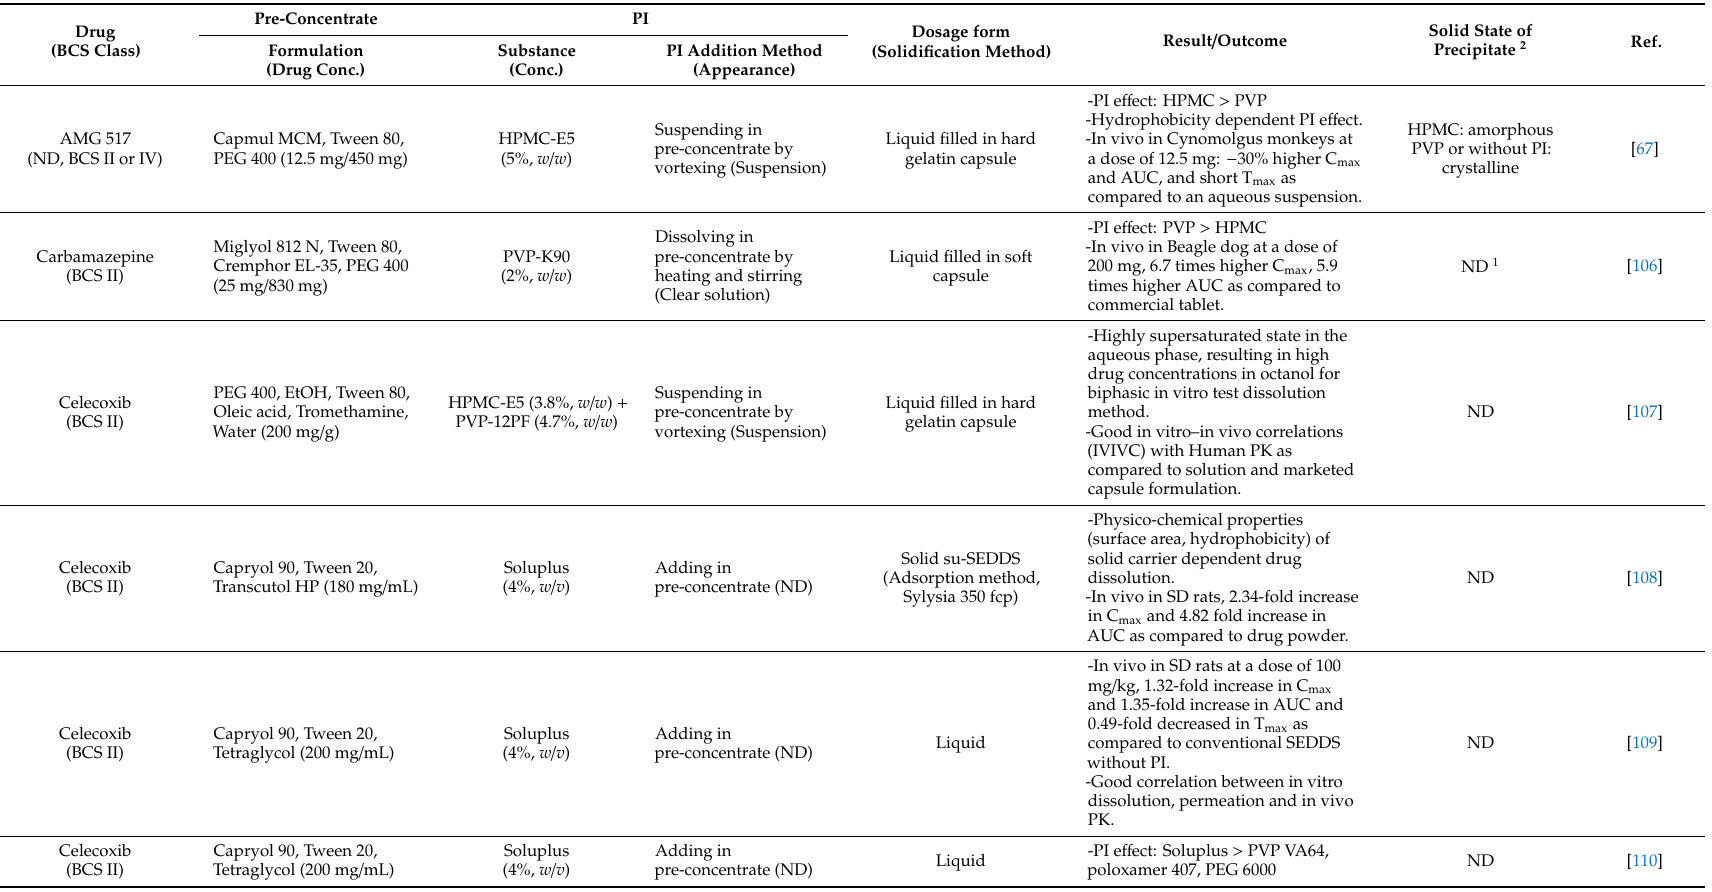
Table 2. List of drugs that have been formulated into supersaturable self-emulsifying drug delivery system